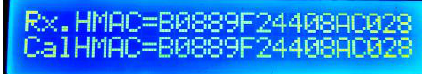
Figure 15. Master node’s decryption result display.